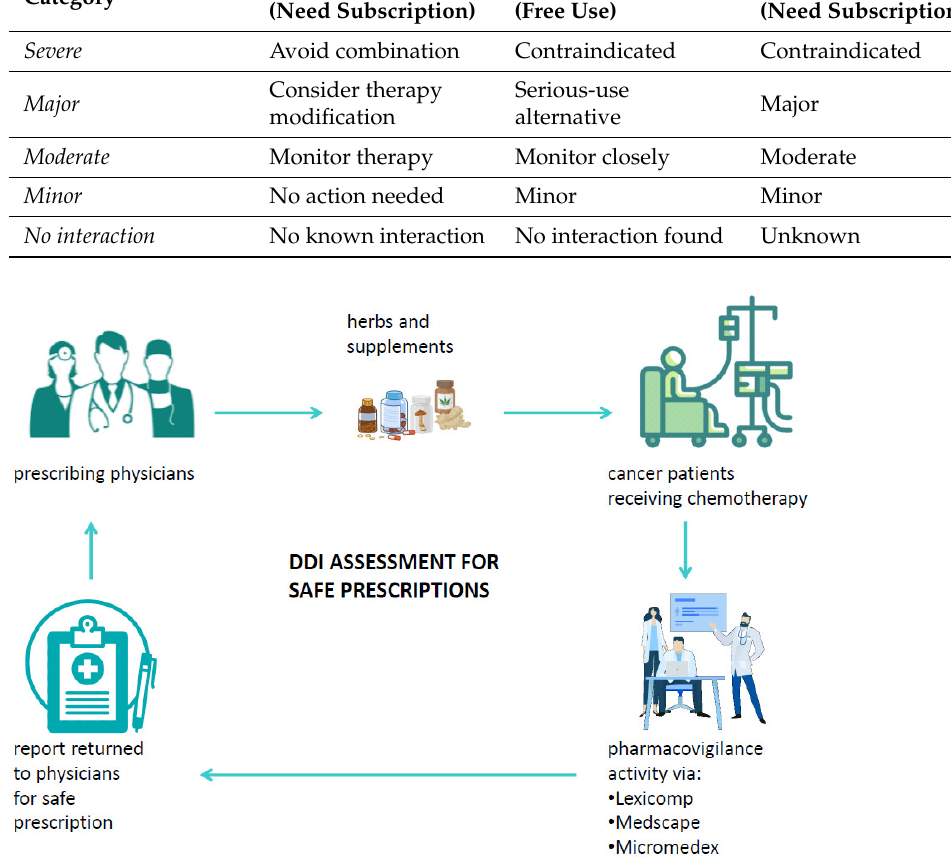
Figure 4. Suitable pharmacovigilance activity via DDI checker programs in cancer patients’ journey.